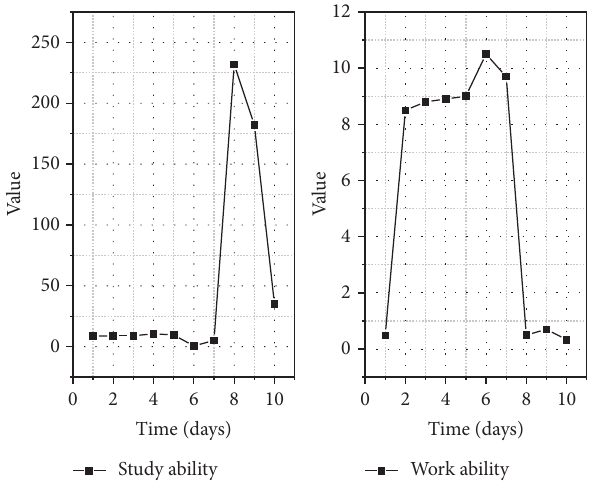
Figure 7: Decision tree test